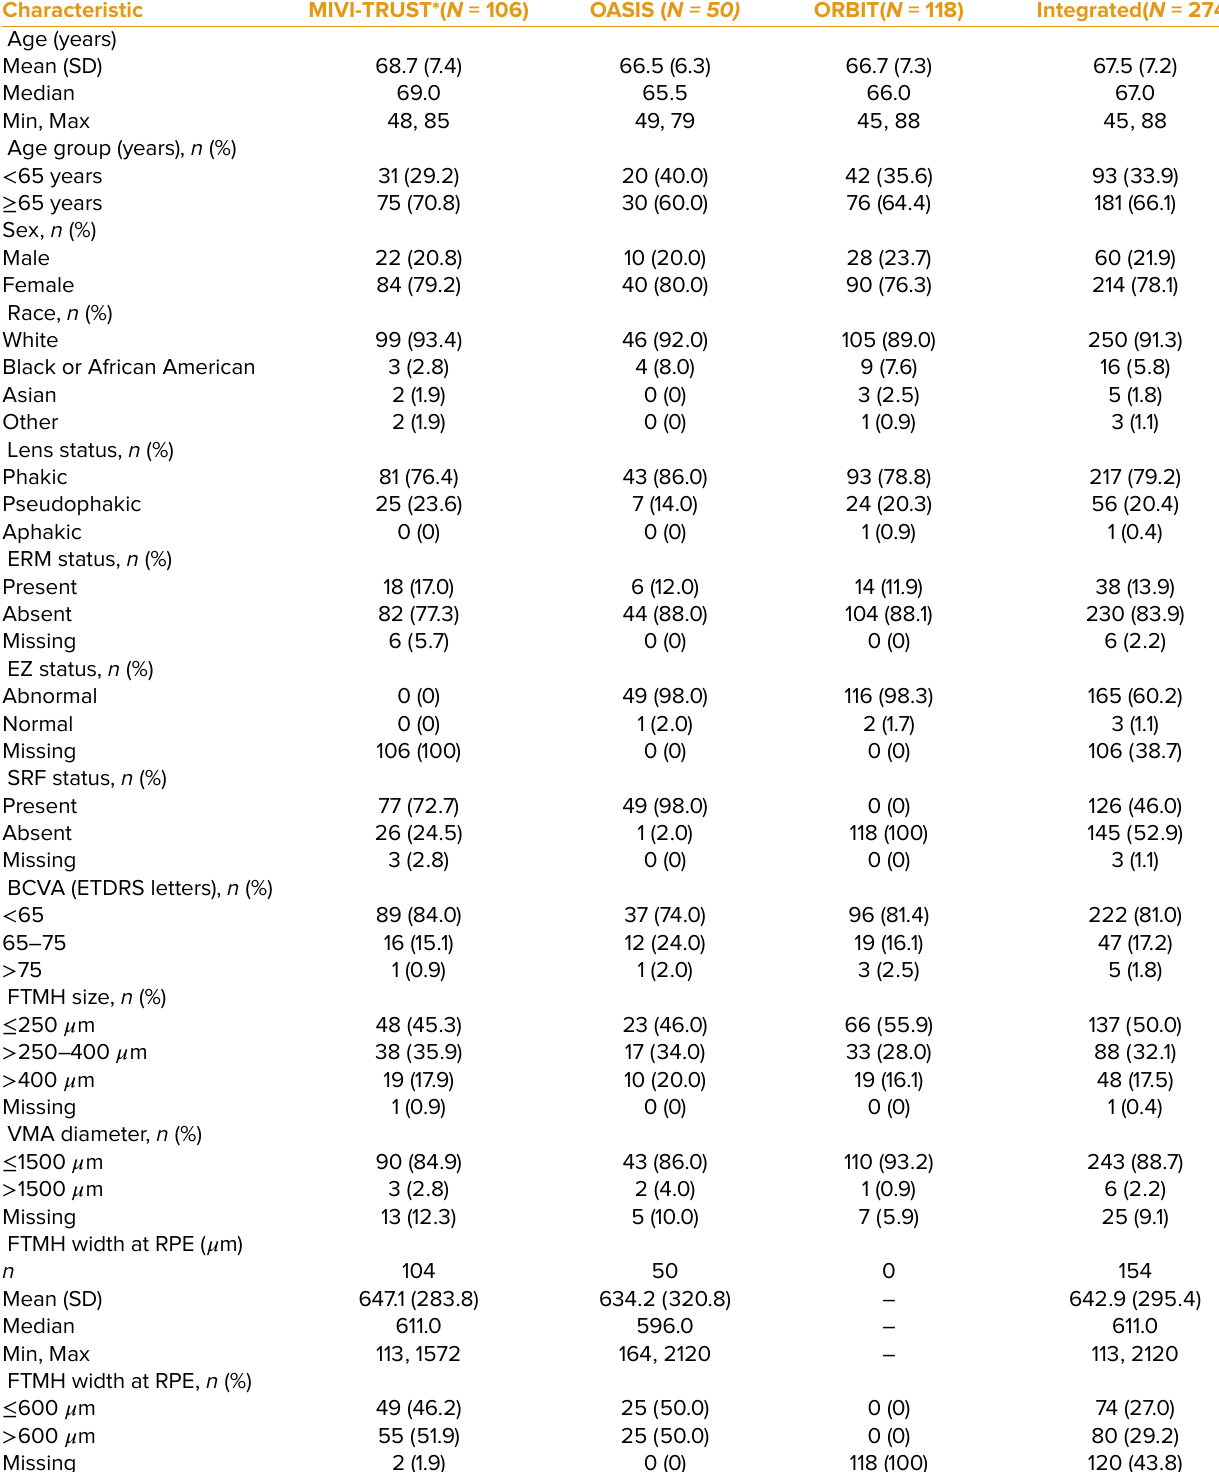
Table 1. Patient demographics and ocular baseline characteristics in the four studies and the integrated dataset